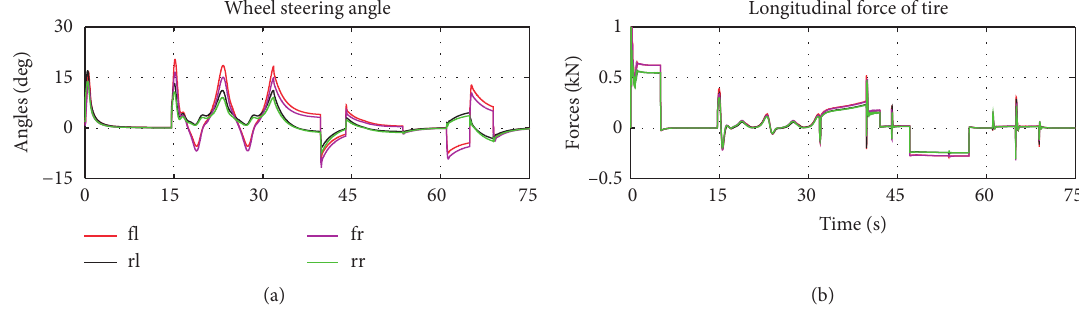
Figure 21: Time histories for steering angles and longitudinal forces of the wheels of the vehicle in the path-following control.